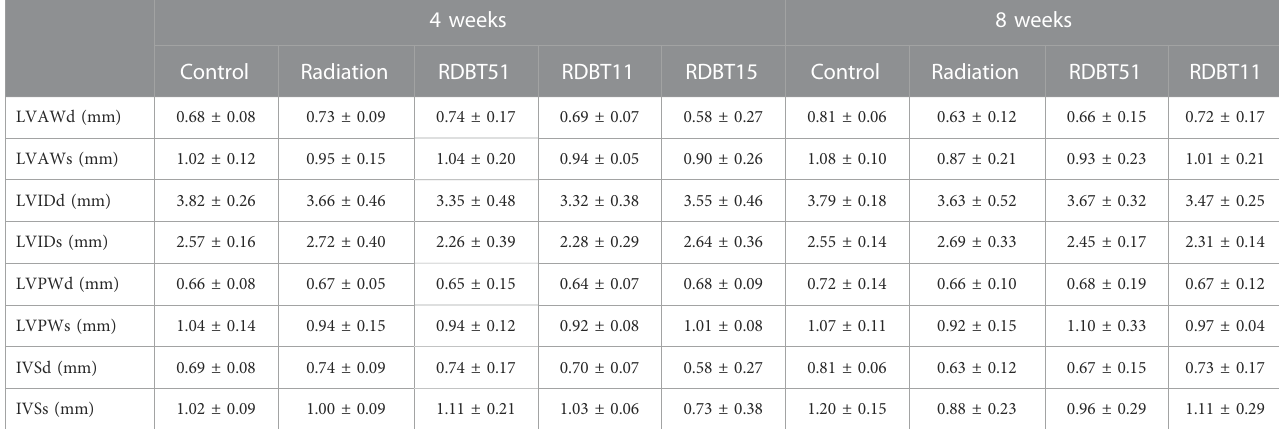
TABLE 1 Left ventricular systolic function and morphologic data obtained from echocardiographic measurement. 4 weeks 8 weeks